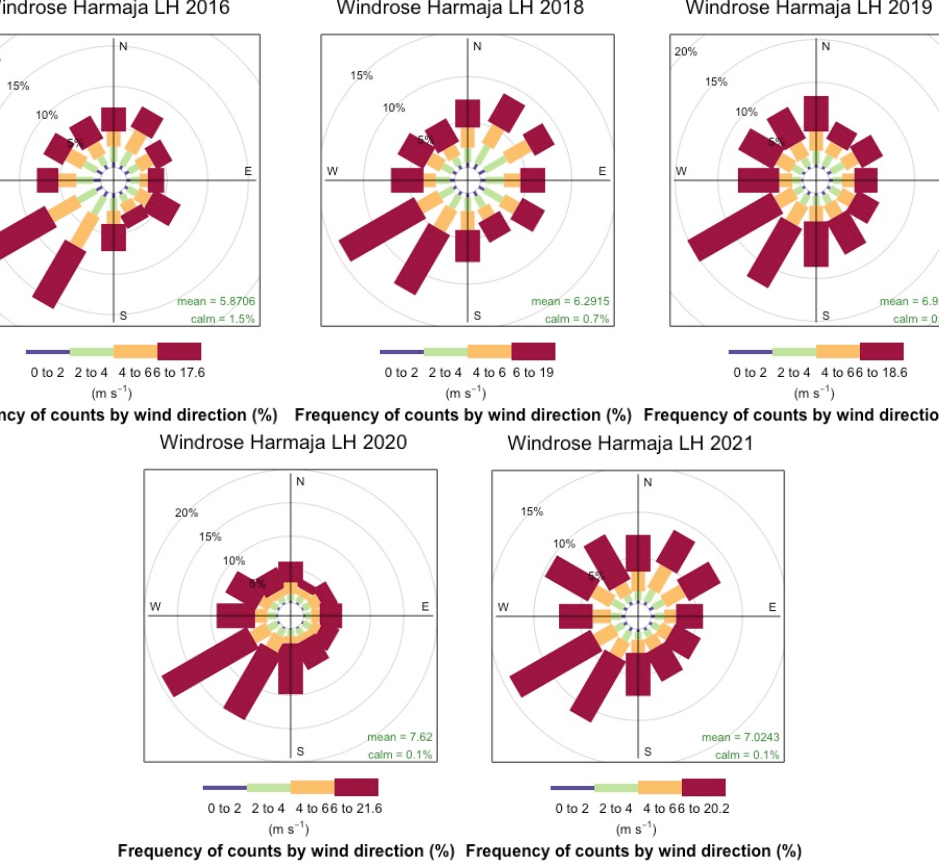
Figure 3. Windroses from Harmaja Lighthouse 2016, 2018–2021. The annual mean concentrations of NO 2 and PM 2 . 5 were below the national limits (40 µg/m 3 for NO 2 and 25 µg/m 3 for PM 2 . 5 ), but above the 2021 WHO guidance limits (10 µg/m 3 for NO 2 and 5 µg/m 3 for PM 2 . 5 ) except for PM 2 . 5 in 2020 as shown on the boxplots (Figures 4 and 5). Exceedances of daily and hourly means at each port terminal are reported in Sections 3.1–3.5 and time series plots for each pollutant can be found in the Supplementary Material. Based on the annual means, port workers, ship crews, passengers and urban area populations exposed to the port emissions are a ff ected by NO 2 and PM 2 . 5 concentra- tions that exceed the WHO recommendations. Figure 4. Boxplot of the measured annual median (black line), interquartile ranges and mean (stars) concentration of NO 2 2016, 2018–2021 at various ports of Helsinki. The blue line is the Finnish/EU limit of 40 µg/m 3 , which was in force during the studied years. The red line is the WHO 2021 rec- ommended limit of 10 µg/m 3 and the orange line the EU proposal of 20 µg/m 3 .